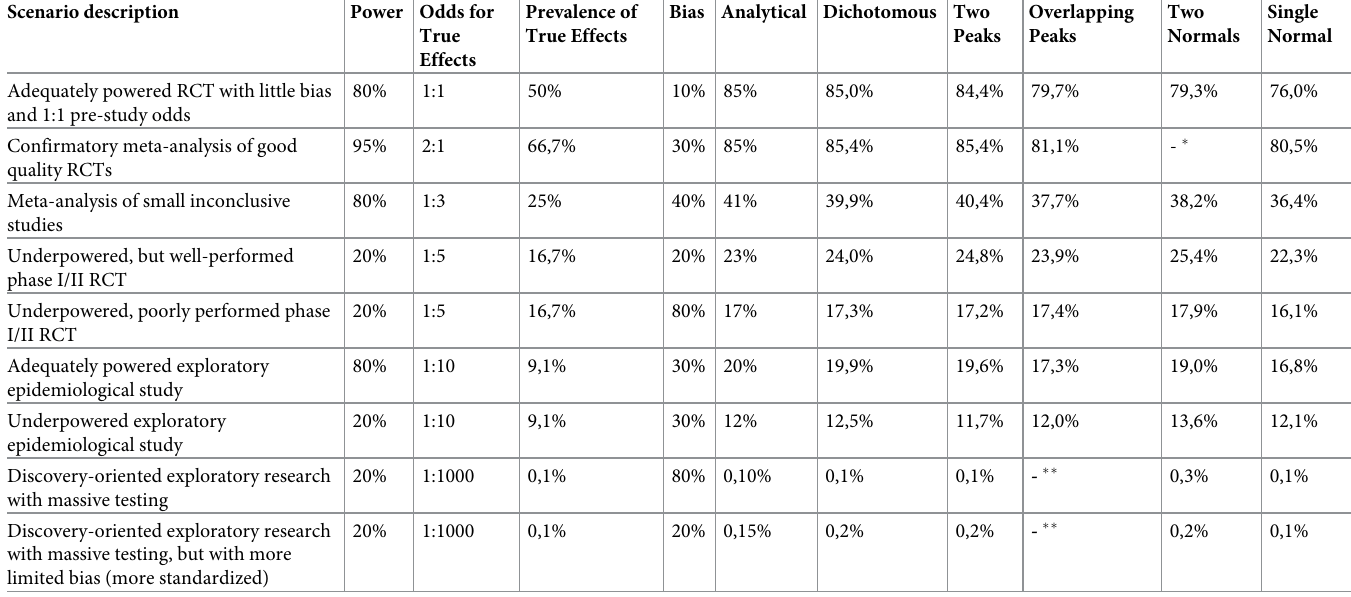
Table 1. Positive predictive value (PPV) for simulated scenarios varying in power, bias and prevalence of true effects (i.e. above the minimum of interest). Scenario descriptions, parameter combinations and the Analytical column are adapted directly from Ioannidis [1]. The remaining columns contain the PPVs for simulations of 5,000 published findings using each of the different effect size distributions in our model. Parameters for the distributions are set so that the prevalence of effects above the minimum of interest approximates the specified odds (see S1 Table for model parameters and achieved prevalences for each scenario). Missing values occur in some sce- narios when the desired prevalence cannot be achieved without changing the minimum effect of interest, thus complicating direct comparisons with other scenarios. � For Two Normals, one cannot obtain a prevalence of 66.7% without changing the minimum effect of interest or the SD of the wider normal, as a normal N(0, 1) has only about 62% of its mass beyond the minimum of interest on both tails. �� For Two Peaks, one cannot obtain a prevalence of 0.1% without changing the minimum effect of interest, as a normal distribution N(0, 0.2) has over 1% of its mass beyond the minimum of interest on both